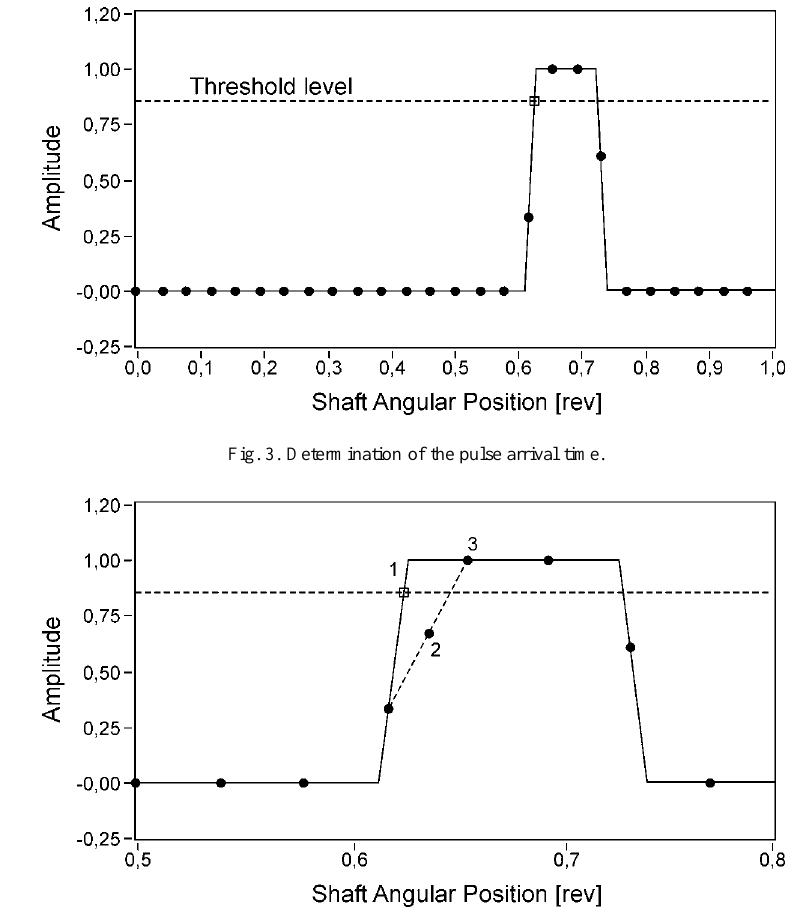
Fig. 4. Interpolation to improve the accuracy in the determination of the pulse arrival time. Key: 1 = exact arrival time, 2 = measured arrival time, and 3 = averaged arrival